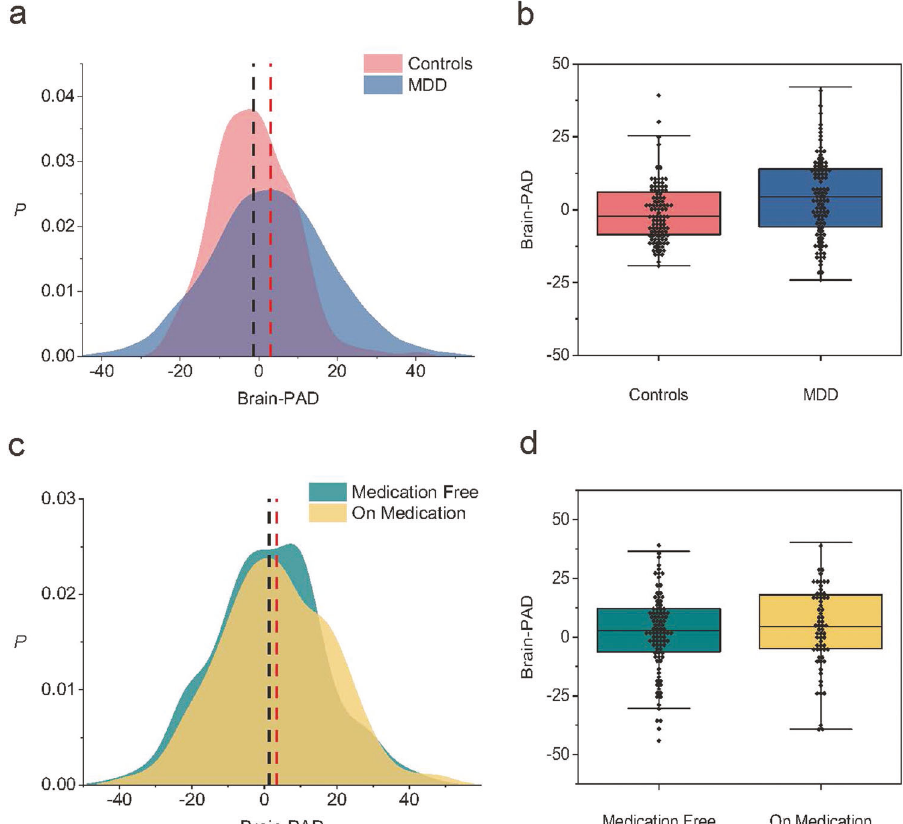
Fig. 4 The brain-PAD in different subgroups. a The brain-PAD in controls and MDD patients. b Group analysis shows that the corrected brain-PAD is signi fi cantly higher in MDD patients than in controls ( p < 0.0001, Cohen ’ s d = 0.31, 95% CI: 2.23 – 3.88). c The brain-PAD in antidepressant users and medication-free patients. d Group analysis shows that the brain-PAD is higher in MDD patients who are taking medication ( + 3.38 years, 95% CI: 1.86 – 4.90) than in those medication-free ones ( + 1.29 years, 95% CI: − 0.14 – 2.72). The difference passes the statistically signi fi cant threshold ( p =